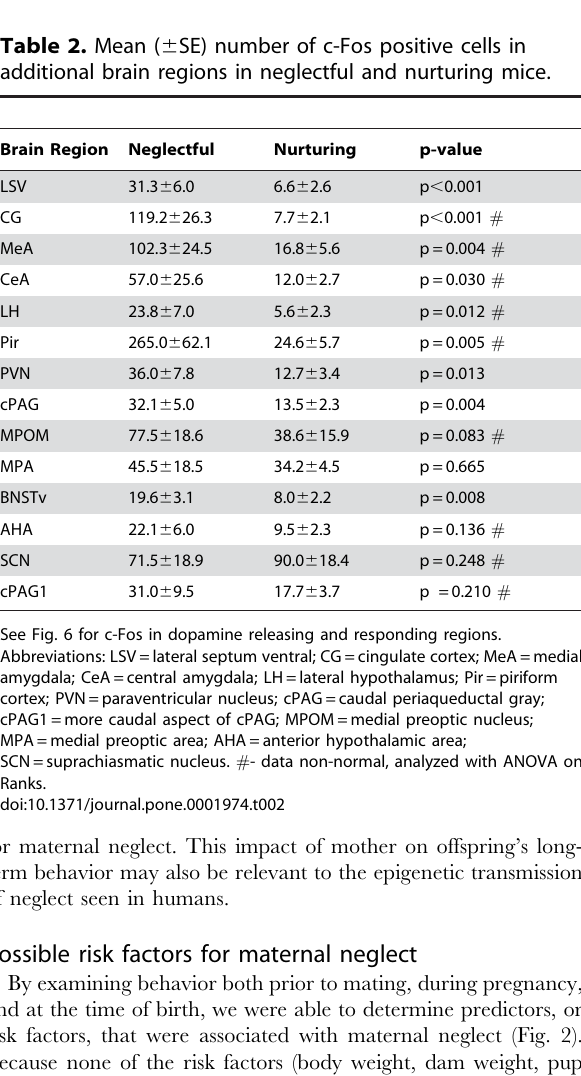
Table 2. Mean ( 6 SE) number of c-Fos positive cells in additional brain regions in neglectful and nurturing mice.